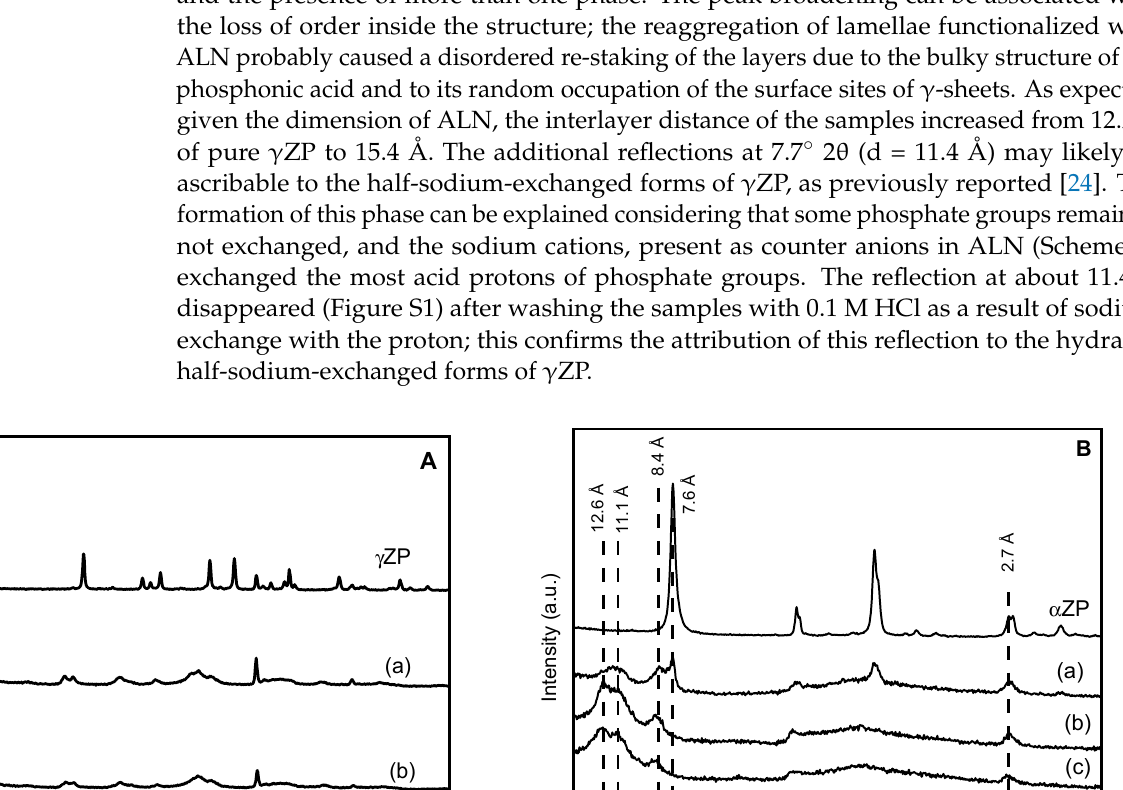
based on α ZP have a fairly disordered